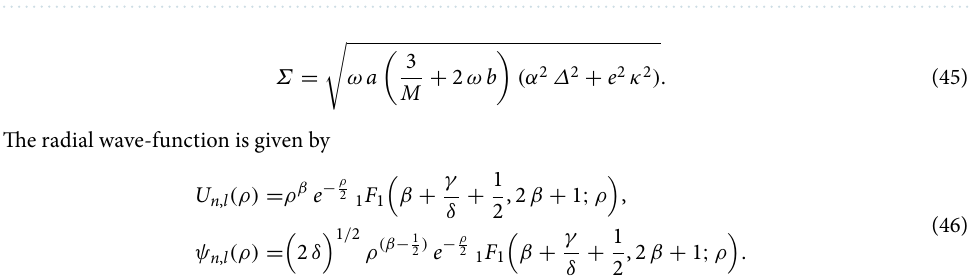
Figure 5. Wave function U n , l keeping fixed M = 1 = b = e , ξ = 1 / 2 [unit of different parameters are chosen in natural units ( c = 1 = (cid:31) )